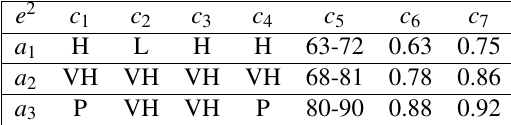
Table 3. Information provided by e 2 expressed in S 7 .